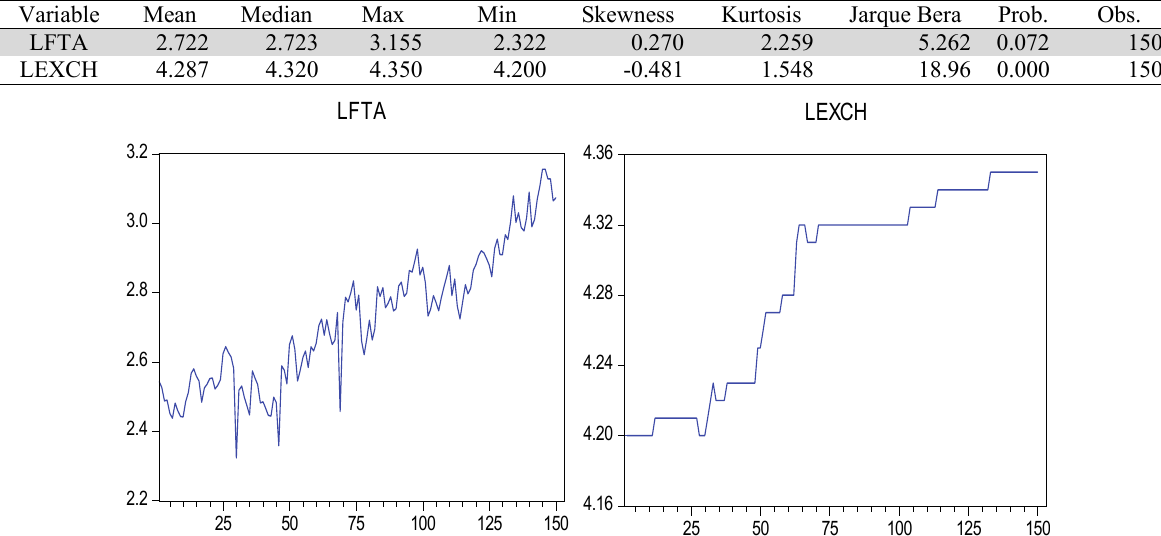
The descriptive statistics for variables